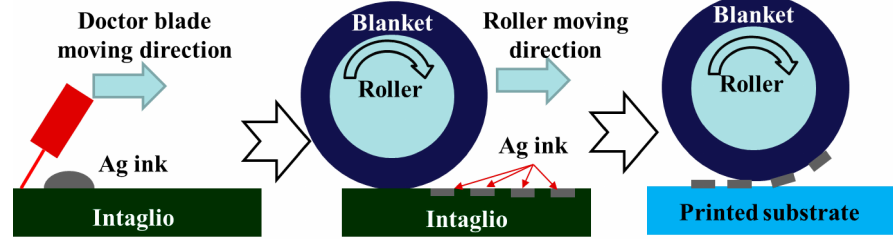
Figure 8. Schematic diagram of gravure offset printing process.